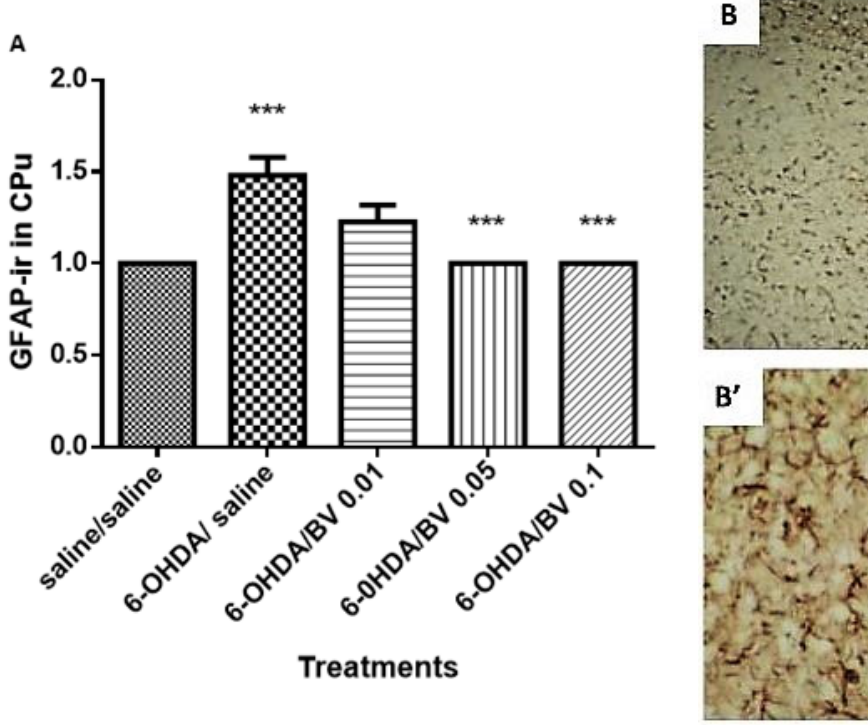
Figure 8. Quantification of GFAP-ir density in the CPu ipsilateral to the lesion ( A ). Representative photomicrographs of brain tissue in the dorsal striatum—CPu—region after immunohistochemistry to GFAP. In ( B ): 6-OHDA/saline group, ( B’ ): 6-OHDA/saline with magnification of 400 × , ( C ): saline/saline, ( D ): 6-OHDA/BV 0.01 mg · Kg − 1 , ( C’ ): 6-OHDA/BV 0.05 mg · Kg − 1 and ( D’ ): 6-OHDA/BV 0.1 mg · Kg − 1 , referring respectively to intrastriatal microinjection and systemic treatment. Magnification of 40 × (***, p < 0.001).